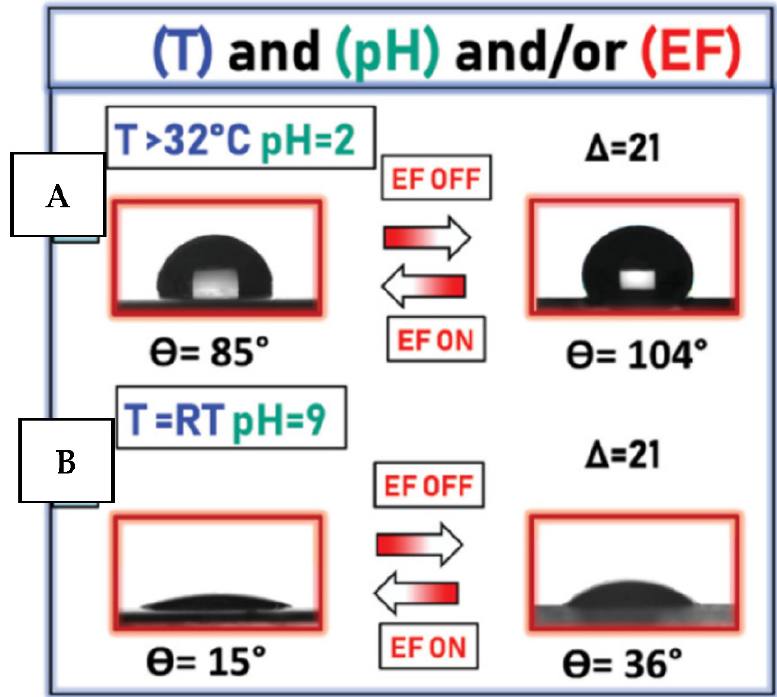
Figure 16. Cyclic application of EF (0.8 V·µm − 1 ) results. The surface is triggered in two different wettability states, introduced by polyacrylic acid and poly( N -isopropyl acrylamide): ( A ) surface is hydrophobic (pH = 2, T = 35 °C), ( B ) surface is hydrophilic (pH = 9; room temperature). Reprinted with permission from ref. [150]. Copyright 2012 Wiley.